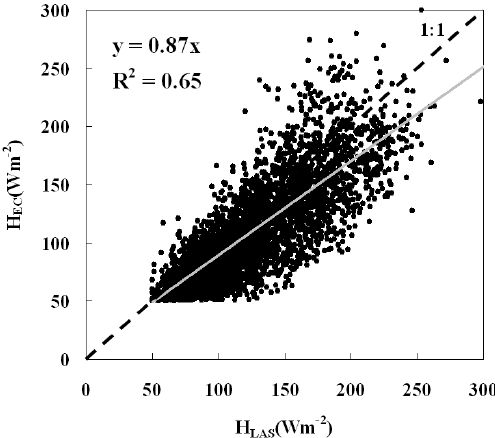
Fig. 7. Comparison of H LAS and H EC at AR when H LAS and H EC >50 W m -2 (11 March to 31 October, 2008, and 1 January to 30 June 2009, 30-min averaging time).